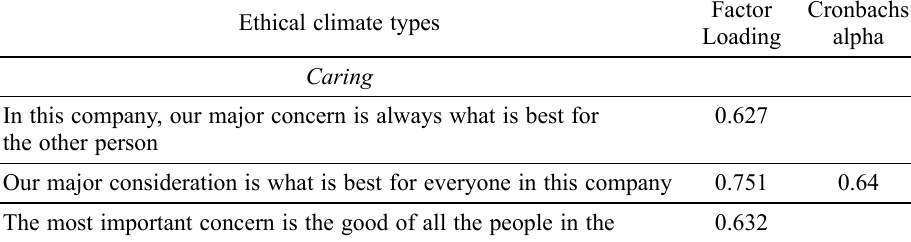
Table 1. Factor loadings and coefficient alpha for ethical climate Ethical climate